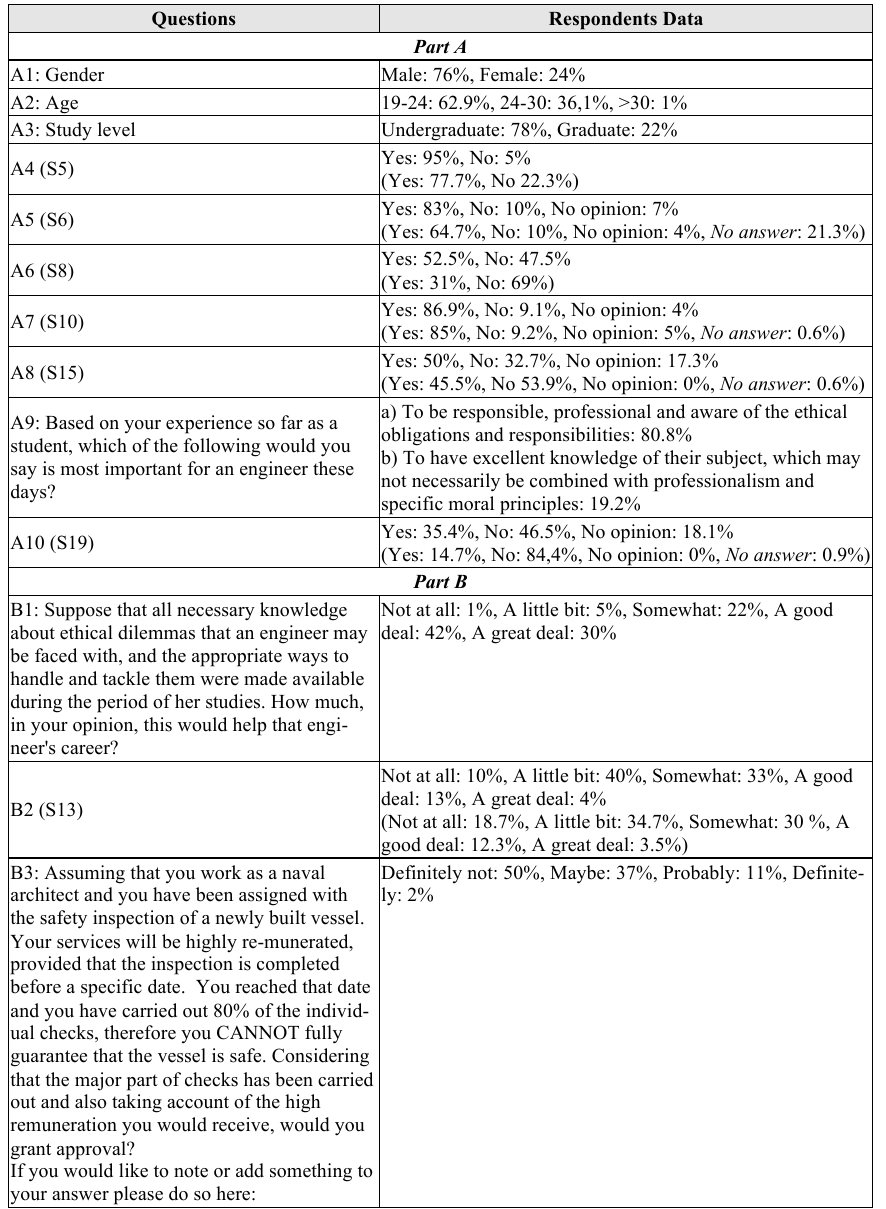
Table 1. Questions and respondents data (data from